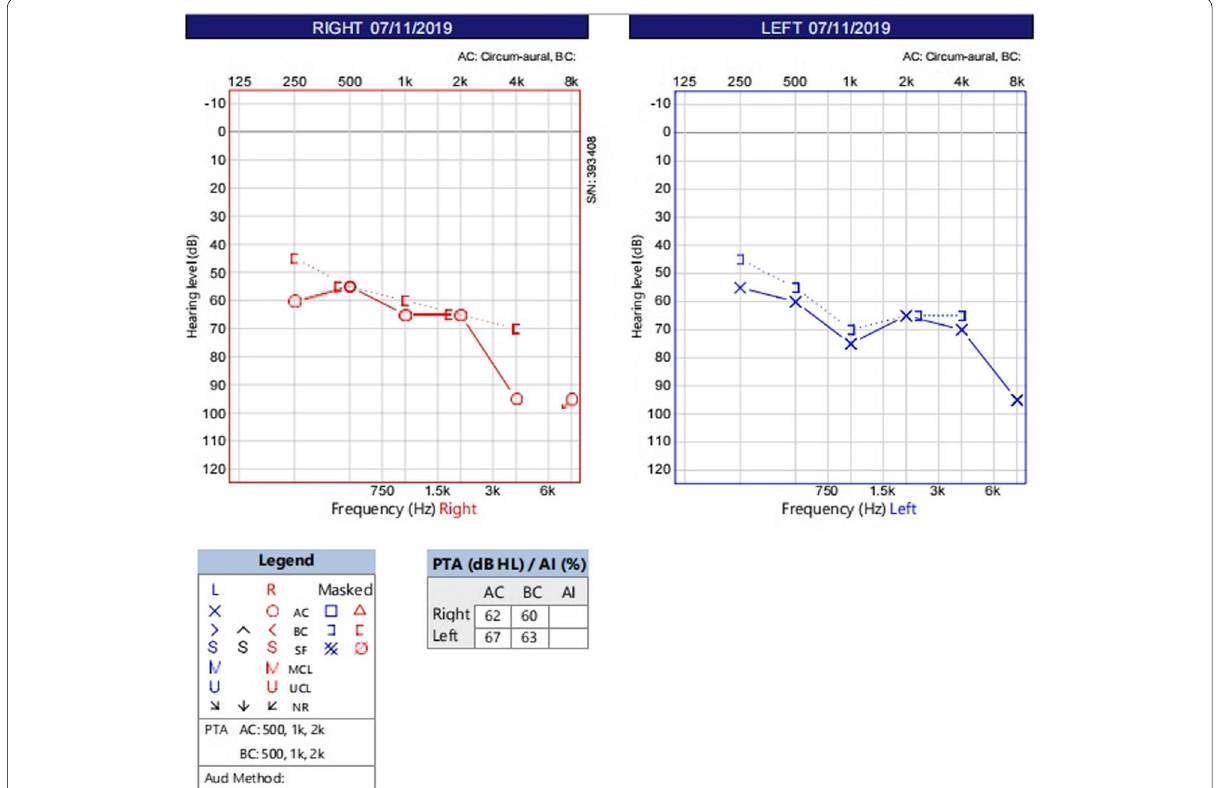
Fig. 1 Late audiogram obtained only after 6 months on osimertinib demonstrating moderate to severe bilateral sensorineural hearing